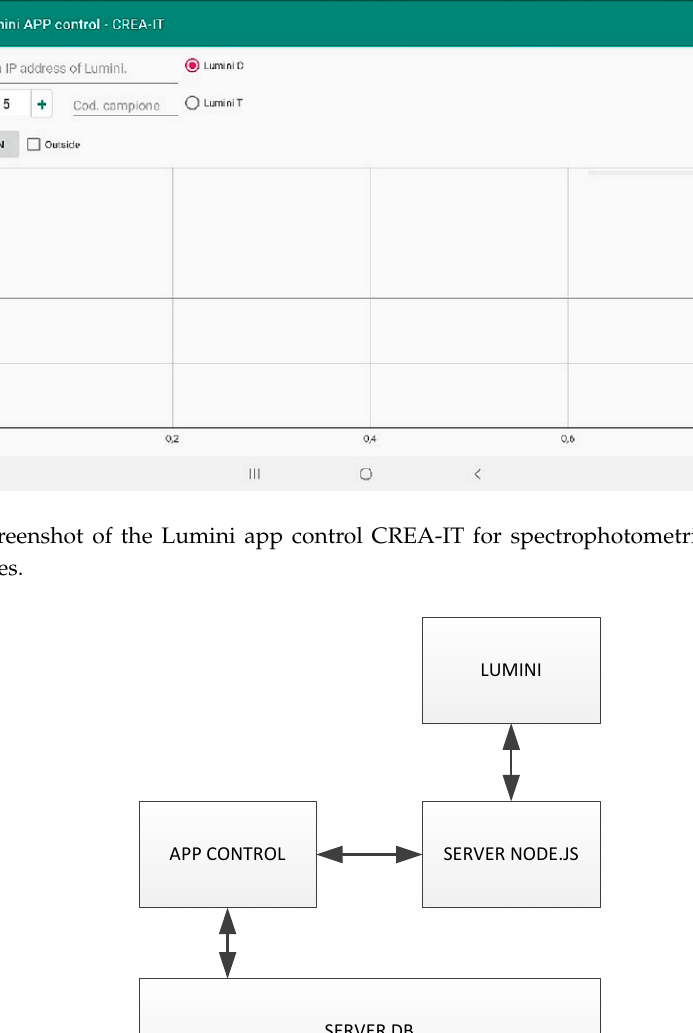
Figure 3. Screenshot of the Lumini app control CREA-IT for spectrophotometric acquisitions of EVOO samples.